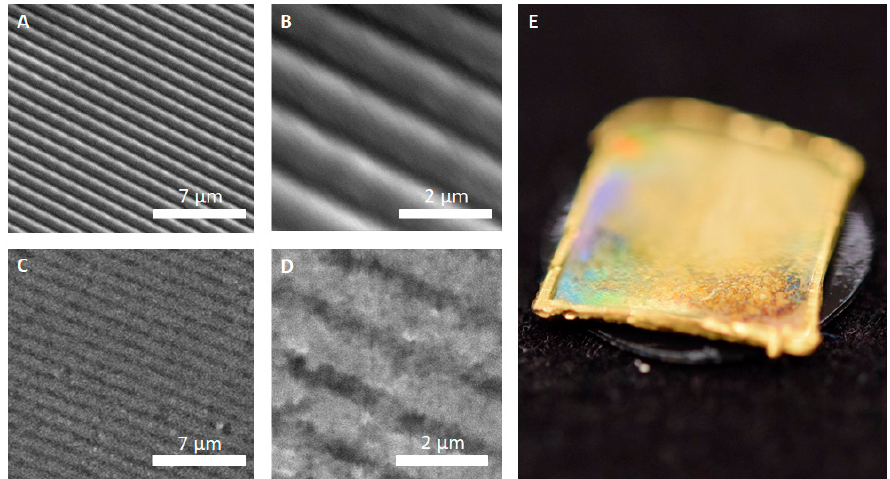
Figure 2. Comparison between the original grid foil and the copper replica. ( A ) Scanning electron microscopy (SEM) image of the grid foil showing periodic ripples with a width of 1 µm; and ( B ) higher maginification SEM image of the grid foil’s surface. ( C ) SEM image of the replica; and ( D ) higher magnification SEM image of the replica’s surface. ( E ) The surface of the all-metal replicated grid foil shows the iridescent light scattering that is typical for surfaces with periodic microstructures. Replications of biological samples were produced specimen of Texas horned lizard ( P.